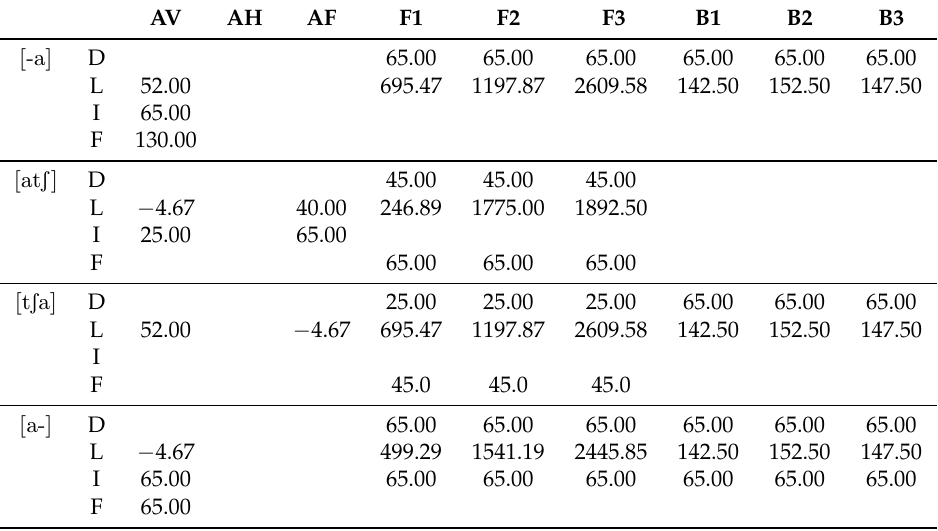
Table 5. Estimated acoustic parameters per